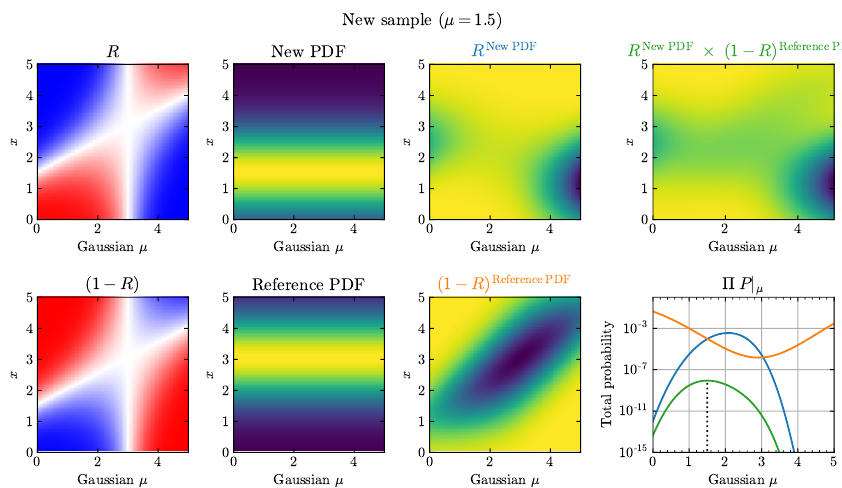
Figure 17. The classifier is now applied to a new unknown sample and the reference sample. The upper left panel shows the classifier output R , which is the probability for a point in the space to belong the scanned sample. Similarly, (1 − R ) is the probability to have come from the fixed sample, and is shown in the lower left panel. The probability density for the new set and the reference set are displayed in the second column, where neither depends on the model parameter µ . The third column displays the classifier output (R or 1-R) convolved with the probability distributions. The total probability is displayed in the top right panel; it is the product of the individual probabilities for each sample in the datasets. In the bottom right panel, the product of the individual probabilities along the y axis is shown as a function of the model parameter. The blue, orange, and green lines denote the probabilities for the new sample, the reference sample, and the combination, respectively. The green line is maximized at the value of the unknown parameter used to generate the new